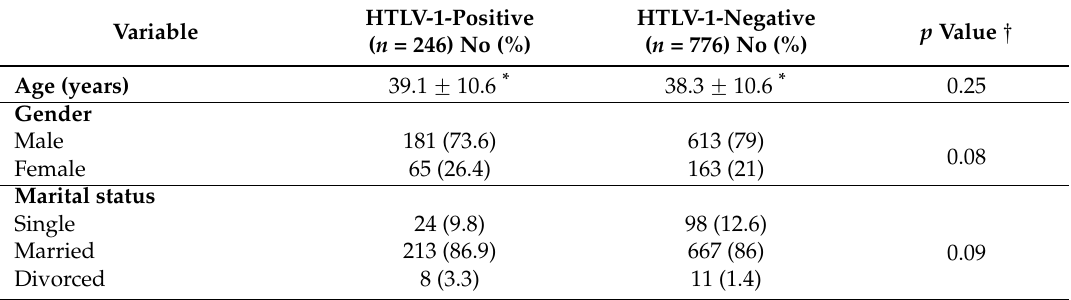
Table 2. Demographic and socio-economic features associated with HTLV-1 infection in blood